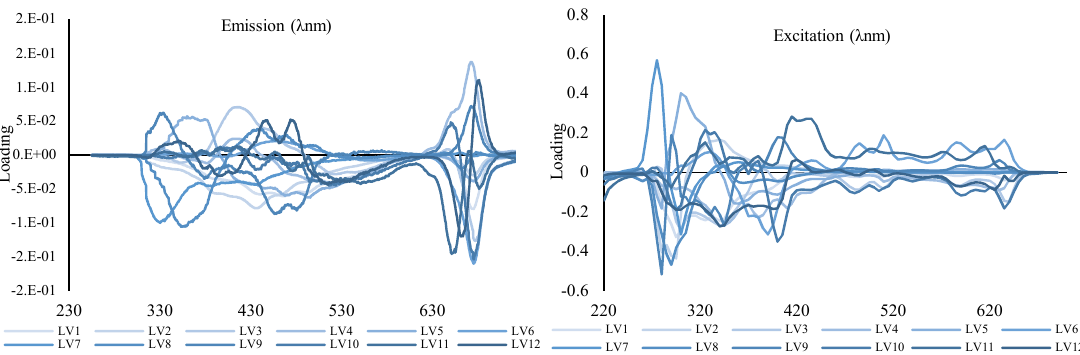
Figure 4. Loading obtained for emission (left) and for excitation (right) using 12 components obtained using DN-PLSR.